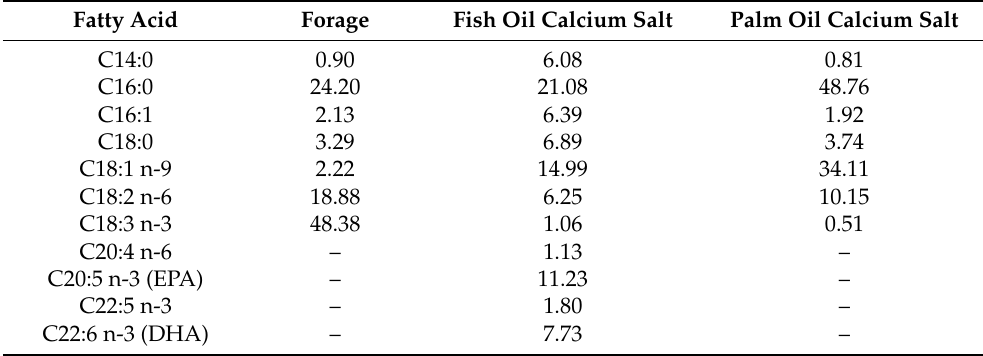
Table 1. Fatty acid compositions (mg fatty acid/100 mg total fatty acids) of the forage diet and the fat